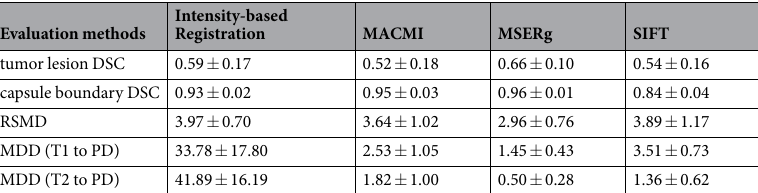
Table 1. Quantitative evaluation of representation-based registration on the clinical and synthetic testing sets. (N = 25 for both datasets) The table shows the mean and the standard derivation of tumor DSC, prostate boundary DSC and landmark RMSD for clinical dataset and MDD for synthetic dataset. Note that the greater the DSC, the lower the RMSD and MDD indicate the more accurate result.